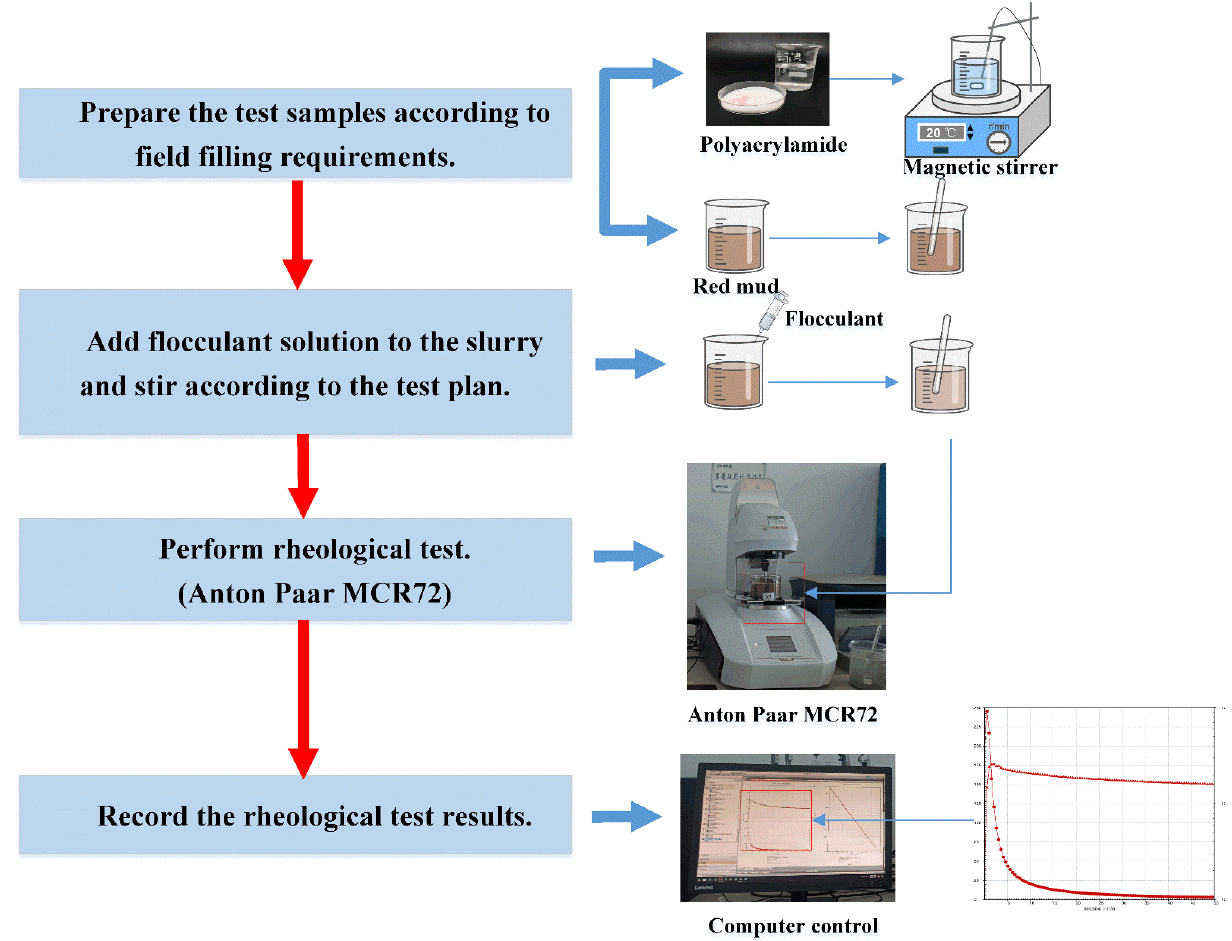
Figure 2. Experimental flow